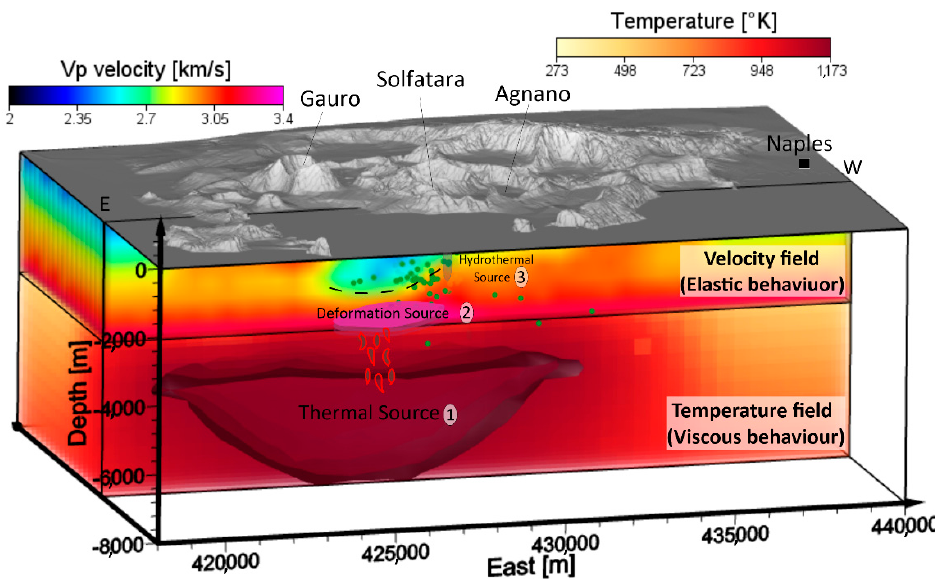
Figure 12. Conceptual model of the Campi Flegrei volcanic system. Schematic view of the caldera system with three different sources and the Vp velocity/conductive thermal field. (1) Thermal deep source from [38,39] represented by the isothermal surface of 1173 K; (2) deformation source from this study and also from [10]; (3) hydrothermal system and fluid source from [16,34]. The green circles represent the earthquake hypocenters for the 2011–2013 time interval. Exaggerated × 2 vertical scale.